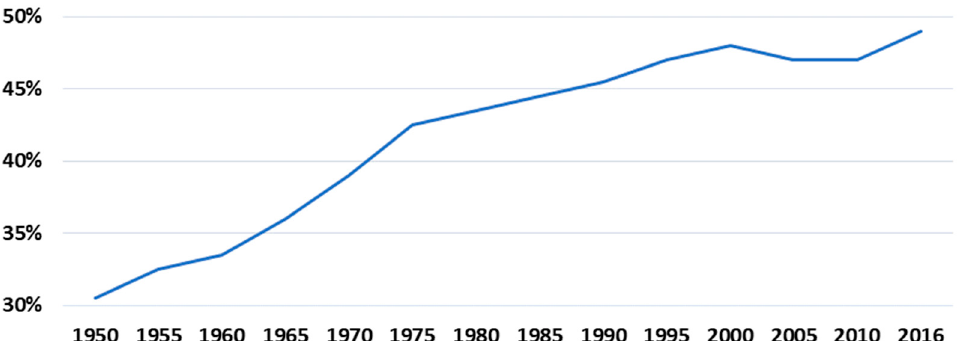
Figure 5. Share of women in the total number of employees in Poland, based on GUS, women and men in the labor market (2004–2018).